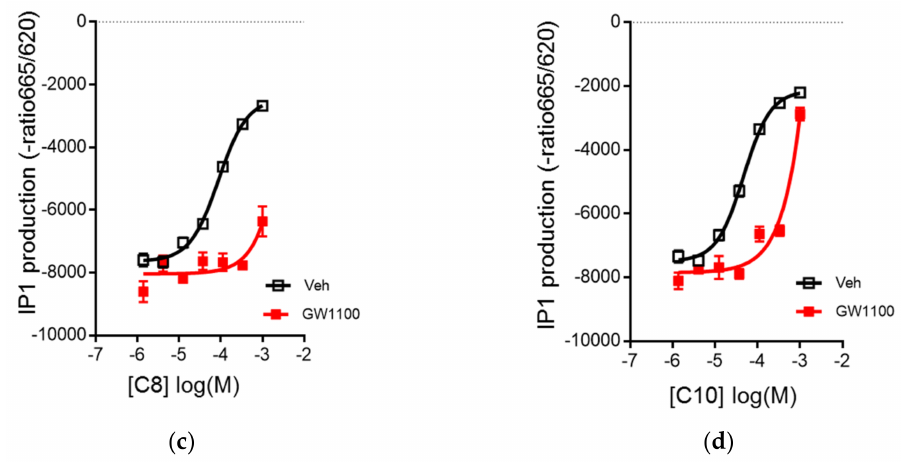
Figure 2. Activation of GPR40 by medium chain fatty acids, C8 and C10, in Chem1-GPR40 cells. ( a ) Dose–response curves of C8 in the presence of C10; dose–response of IP1 production with C8 activation in the presence of increasing concentrations of C10 and ( b ) dose–response curves of C10 in the presence of C8; C10 in the presence of increasing concentrations of C8. ( c ) Dose–response curves of C8 in GW1100; inhibitory effect of the GPR40 antagonist, GW1100, on the dose–response accumulation of IP1 by C8 or by ( d ) dose–response curves of C10 in GW1100; C10 in Chem1-GPR40 cells. Curves represent as means + SD of eight experimental